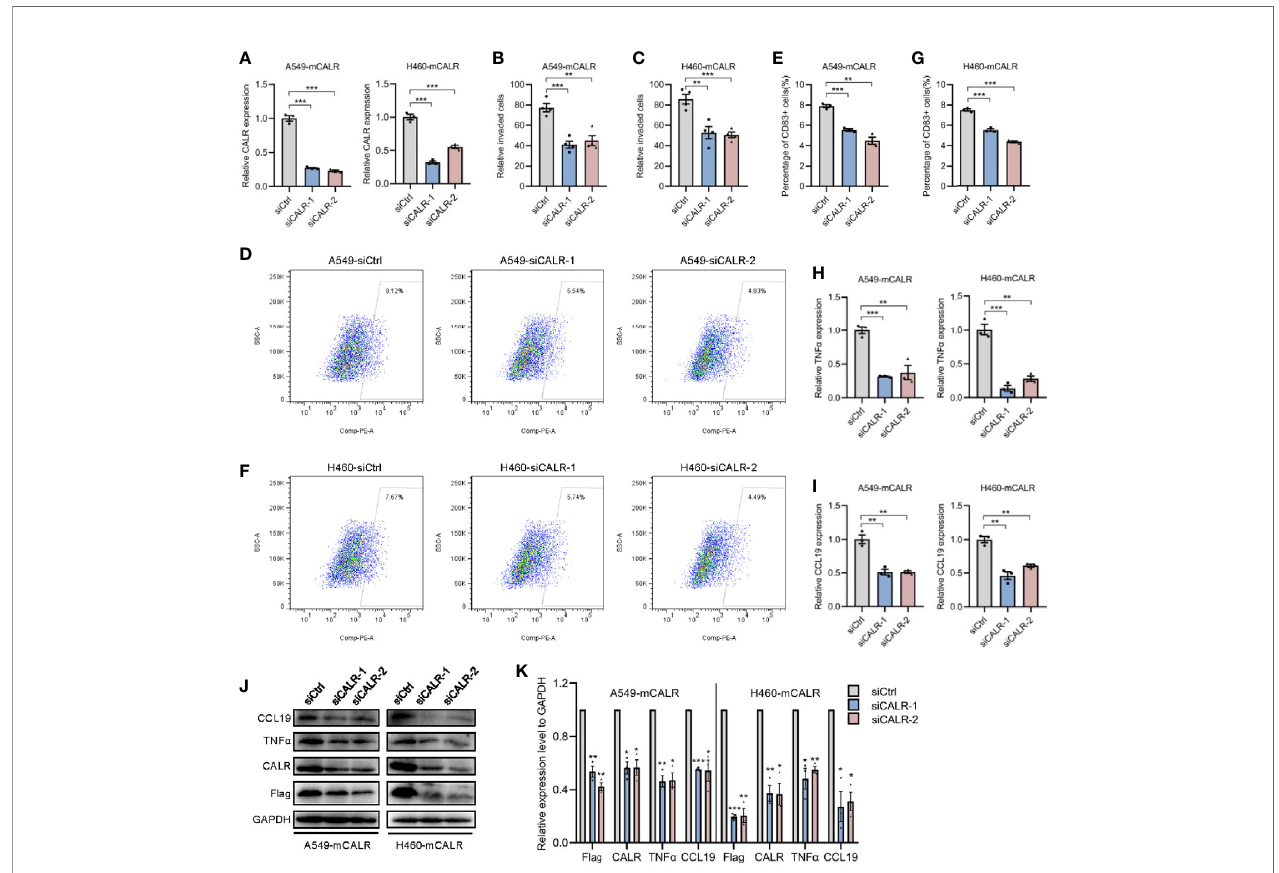
FIGURE 3 | mCALR silence inhibits the migration and maturation of DCs by decreasing the secretion of TNF a and CCL19. (A) The relative mRNA expression levels of CALR was detected in siCALR and control groups using real-time PCR; *** P < 0.001. (B, C) The effect of cell supernatants (siCtrl and siCALR) on DC migration was evaluated by migration assay; ** P < 0.01, *** P < 0.001. (D – G) The effect of cell supernatants (siCtrl and siCALR) on DC maturation was determined using fl ow cytometry with PE-anti-human CD83 antibody; ** P < 0.01, *** P < 0.001. (H, I) The relative mRNA expression levels of TNF a and CCL19 were detected in siCALR and control groups using real-time PCR; ** P < 0.01, *** P < 0.001. (J, K) The expression levels of CALR, Flag-mCALR, TNF a , and CCL19 were investigated in siCALR and control groups using western blot; * P < 0.05, ** P < 0.01, *** P <